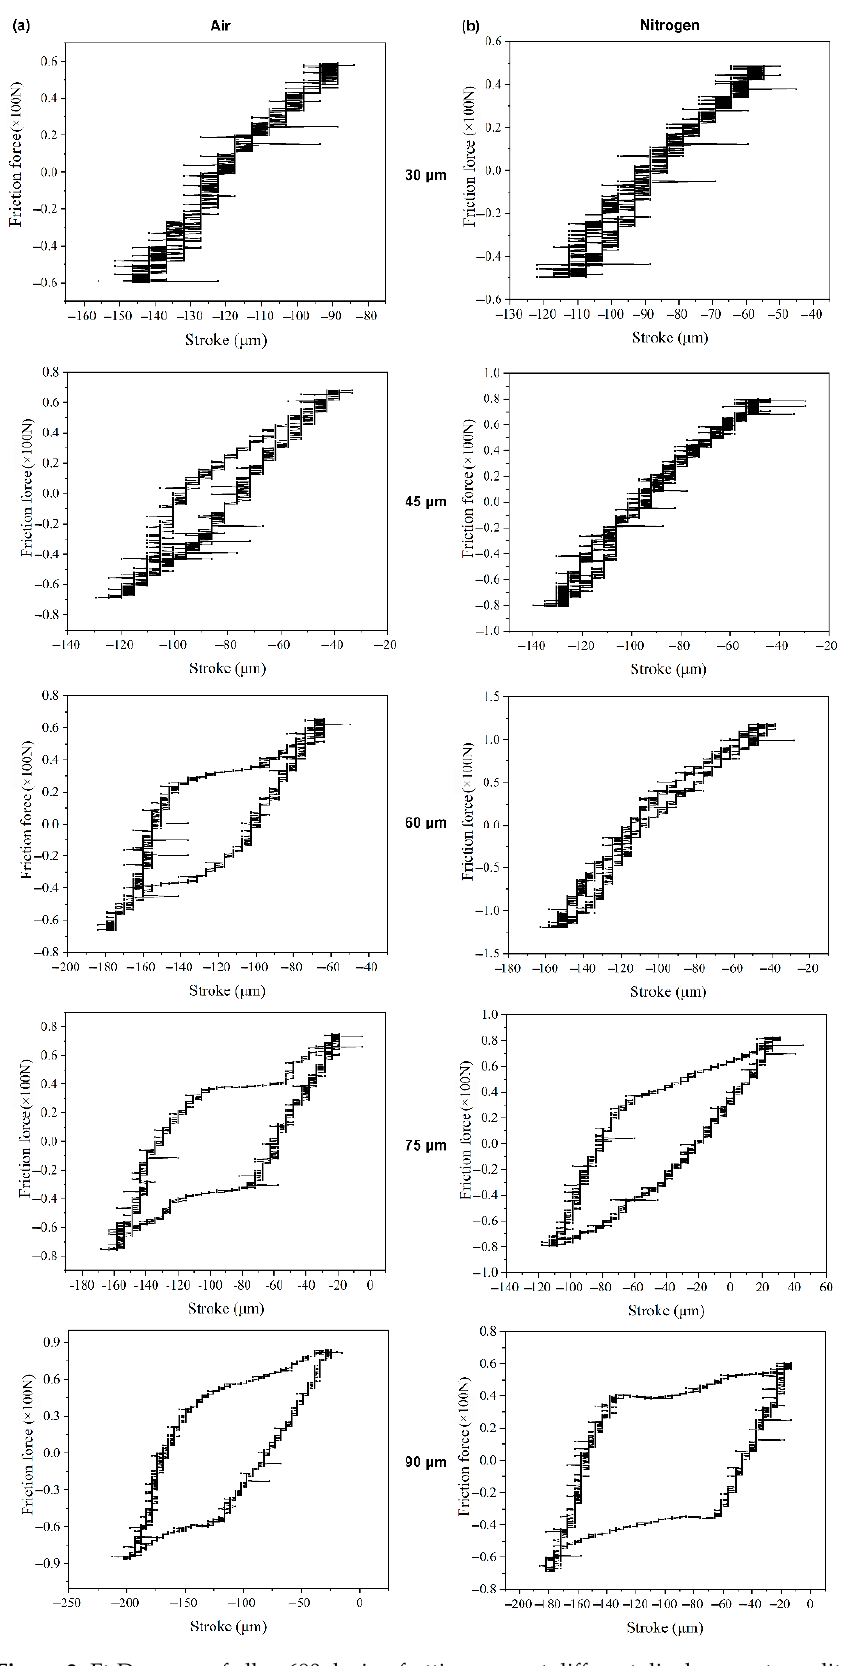
Figure 3. Ft-D curves of alloy 690 during fretting wear at different displacement amplitudes in ( a ) air and ( b ) nitrogen.